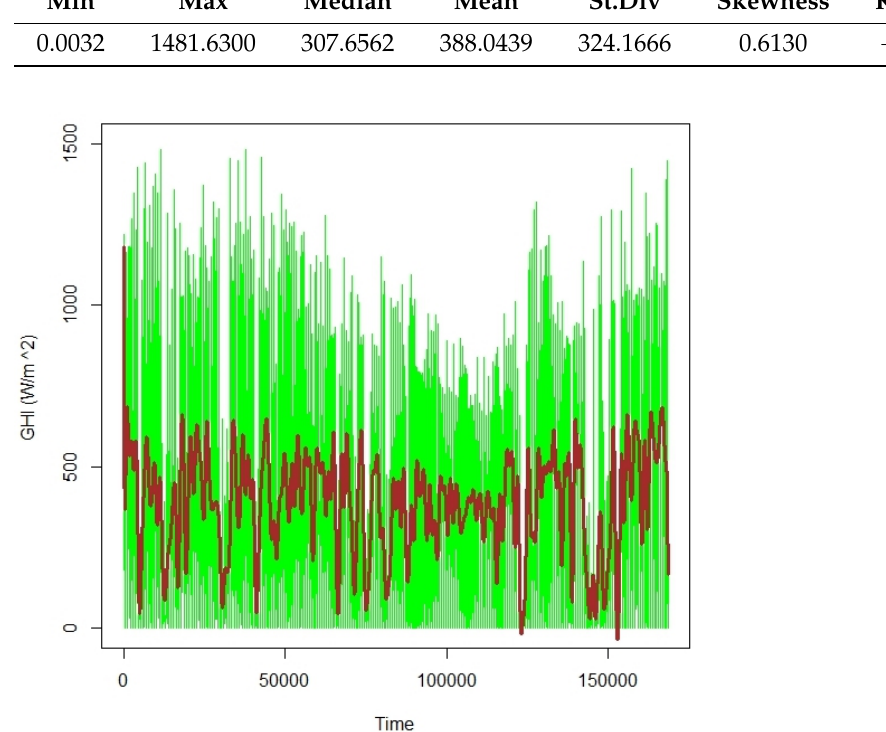
Figure 3. Plot of global horizontal irradiance from 04/01/2020 to 31/10/2020 (green) superimposed with a fitted cubic smoothing spline trend